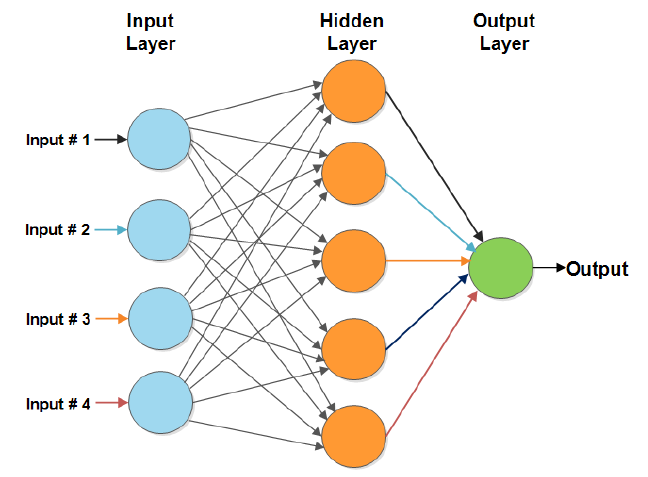
Figure 2. Multilayer